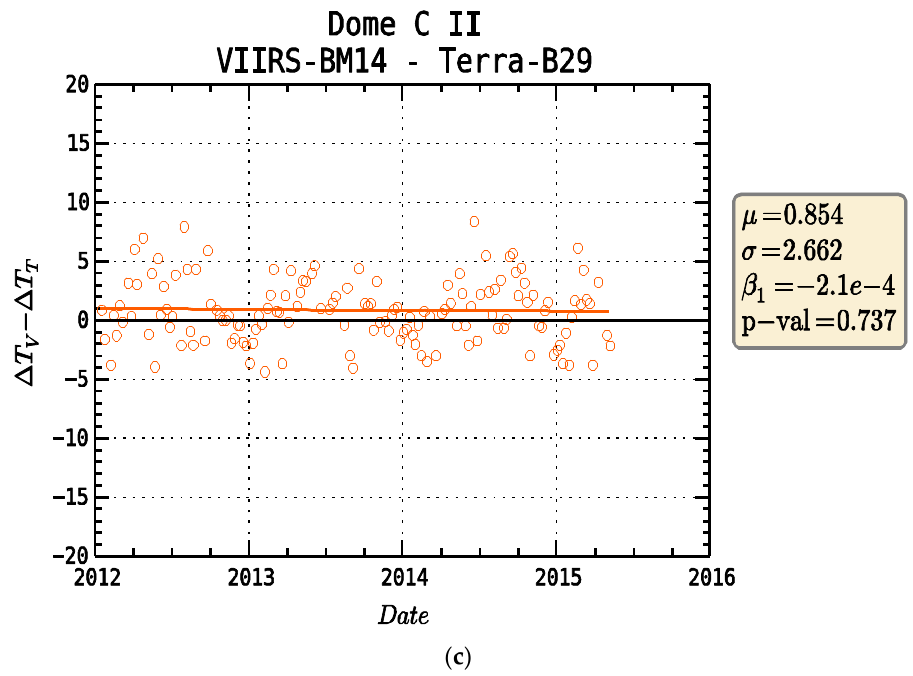
Figure 9. Relative bias trends between S-VIIRS and T-MODIS. ( a ) M15/B31; ( b ) M16/B32; ( c ) M14/B29.